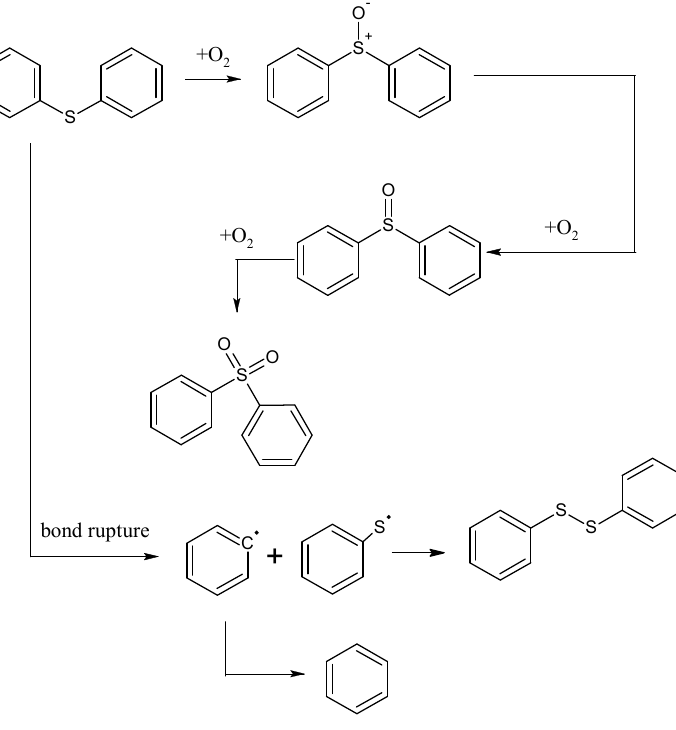
Figure 5. The oxidation pathway of diphenyl sulfide.